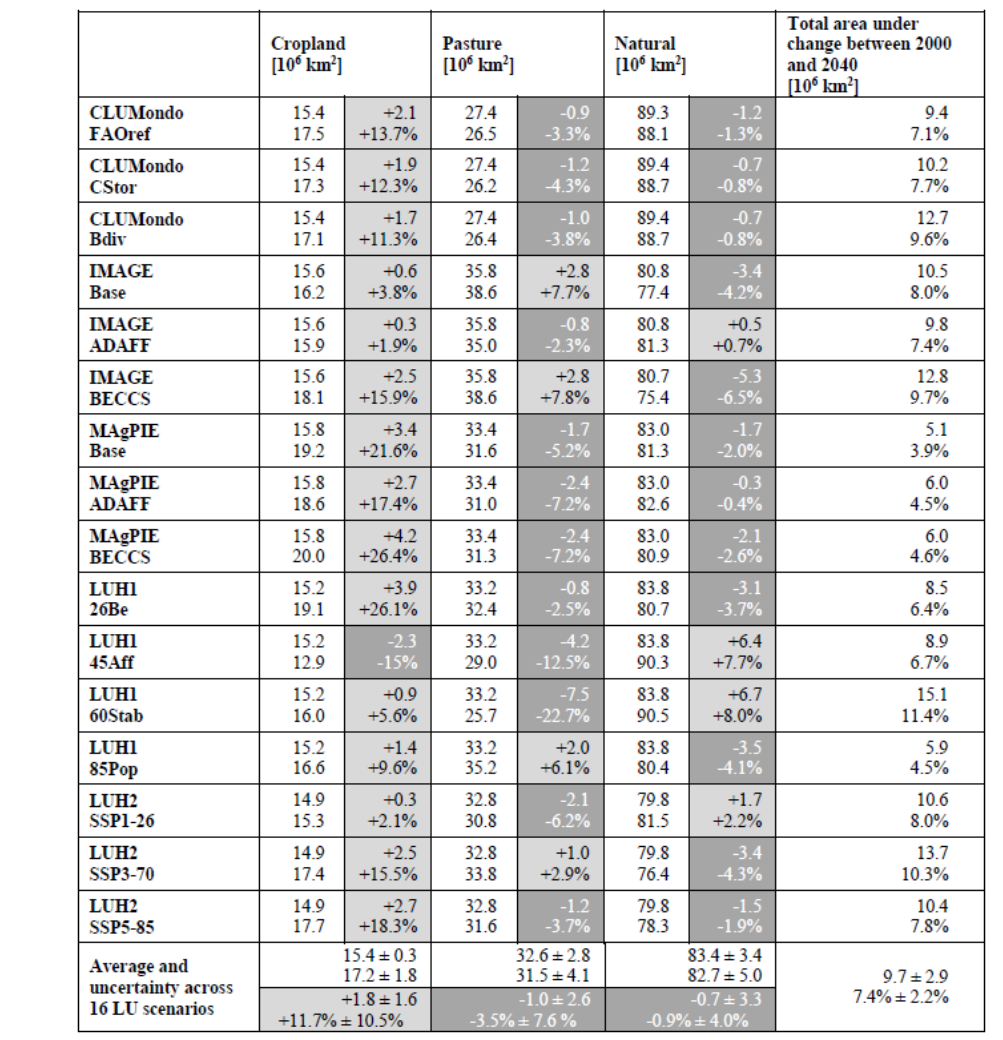
Table 2. Total area of cropland, pasture and natural land as well as the change therein from 2000–2004 to 2036–2040 for 16 land-use scenarios. For each scenario, the left column gives the global total area for 2000–2004 (upper value) and 2036–2040 (lower value) and the right column gives the change from 2000–2004 to 2036–2040 in absolute terms (upper value) and as a percentage relative to the level in 2000–2004 (lower value). Gray shading indicates a positive or negative trend. Total area under change from 2000 to 2040 is given in absolute terms and as a percentage of the global ice-free land area considered in this study (see Sect. 2). Minor deviations in numbers may occur due to